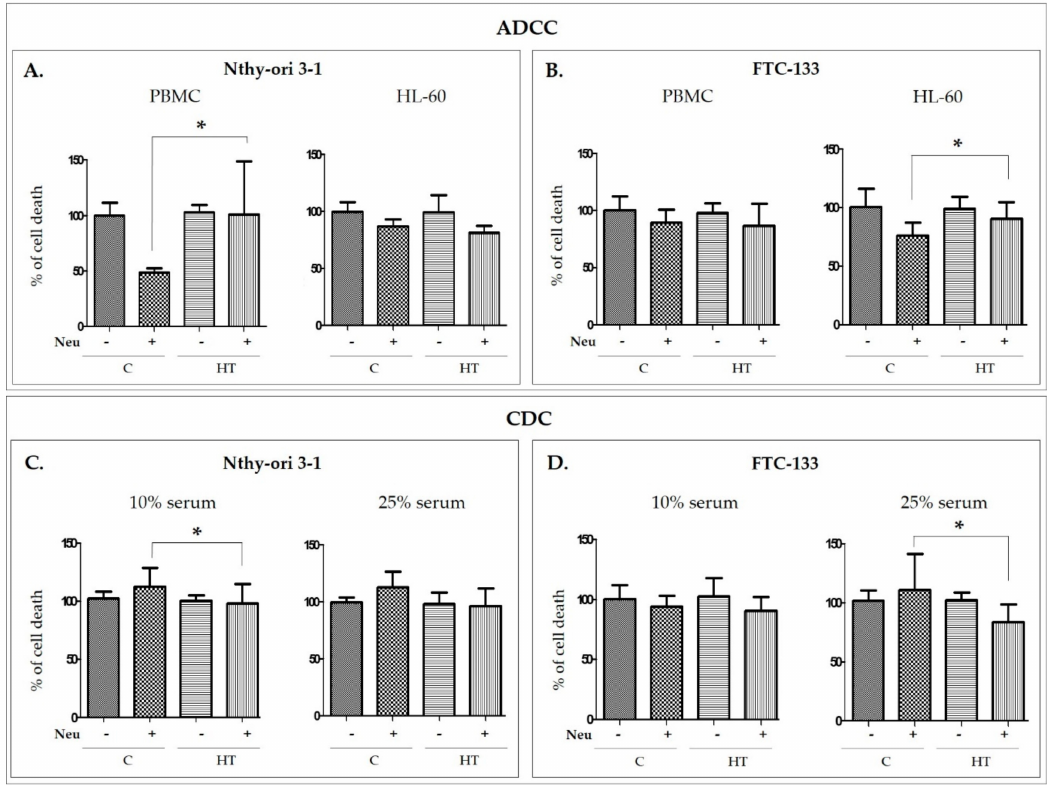
Figure 5. Percentage of Nthy-ori 3-1 and FTC-133 target cell death induced by α 2-3,6,8-neuraminidase (Neu)-treated (desialylated) and intact IgG in ADCC and CDC models. Relative ( A ) Nthy-ori 3-1 and ( B ) FTC-133 cell lysis triggered by desialylated IgG ( + ) and untreated ( − ) isolated from healthy donors ( C , control) and Hashimoto’s thyroiditis patients (HT) and mediated by peripheral blood mononuclear cells (PBMC) and the HL-60 human promyelotic leukemia cell line in the ADCC model. Relative ( C ) Nthy-ori 3-1 and ( D ) FTC-133 cell lysis triggered by desialylated IgG ( + ) and untreated ( − ) from C and HT donors and mediated by 10% and 25% serum from healthy donors in CDC model. The bar graphs represent the percentage of cell lysis triggered by desialylated IgG (Neu + ) versus untreated IgG (Neu − ). The data are shown as means ± SD. The di ff erences between the experimental variants were analyzed statistically by two-way ANOVA with the post hoc Tukey test (* p ≤